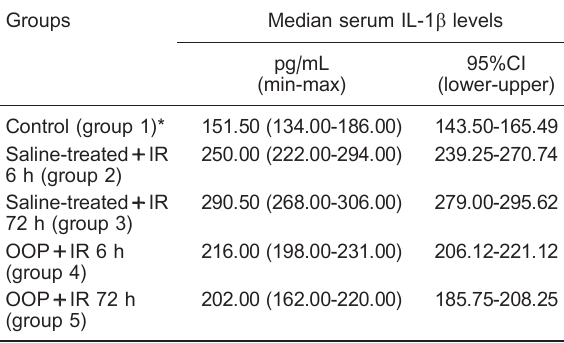
Table 2. Serum IL-1 b levels of control, saline-treated++IR, or OOP++IR groups decapitated at 6 or 72 h after irradiation.